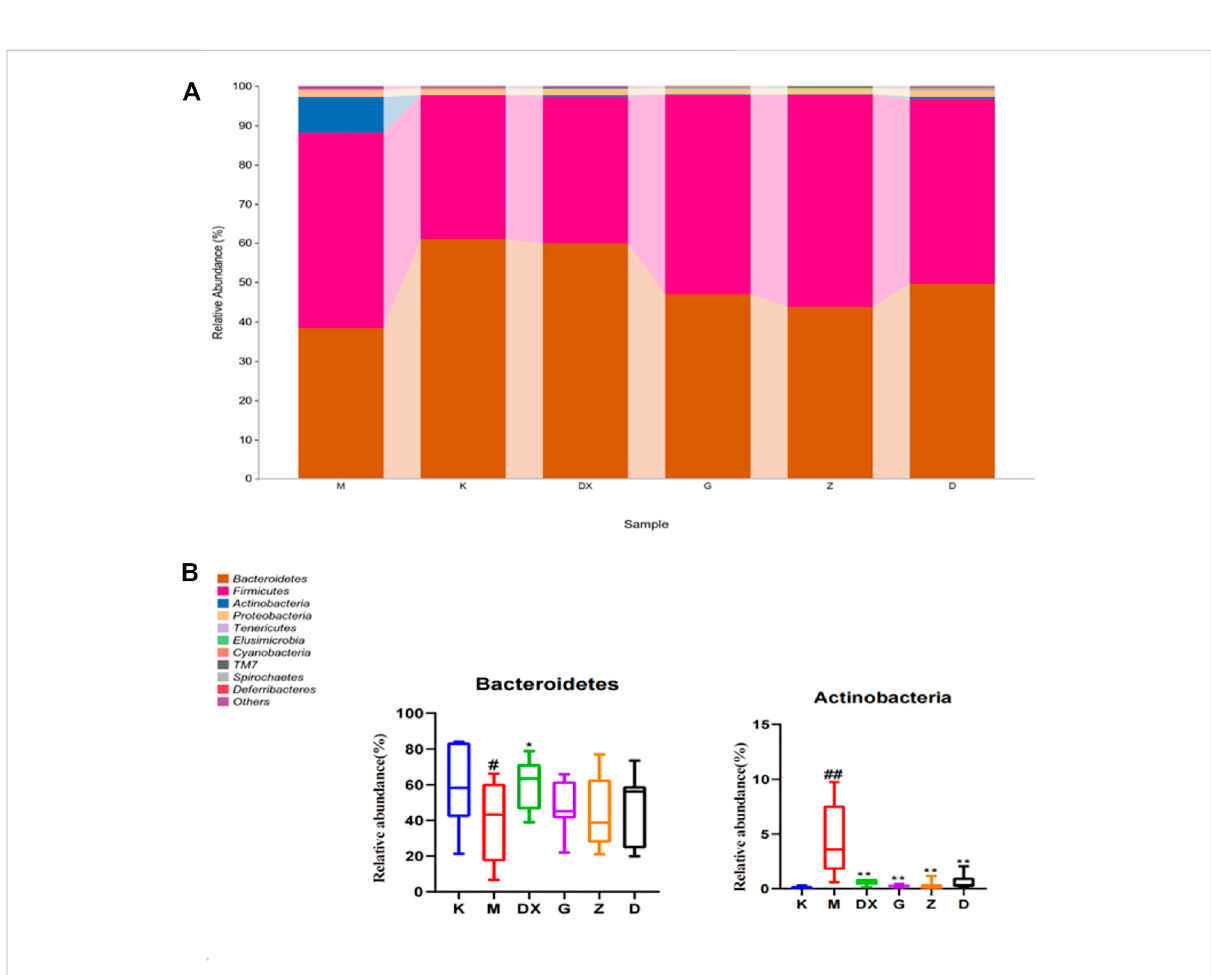
FIGURE10 Effect of R-S on relative abundance of intestinal micro fl ora (A) and signi fi cant changed intestinal micro fl ora (B) of insomniac rats ( n = 7) in